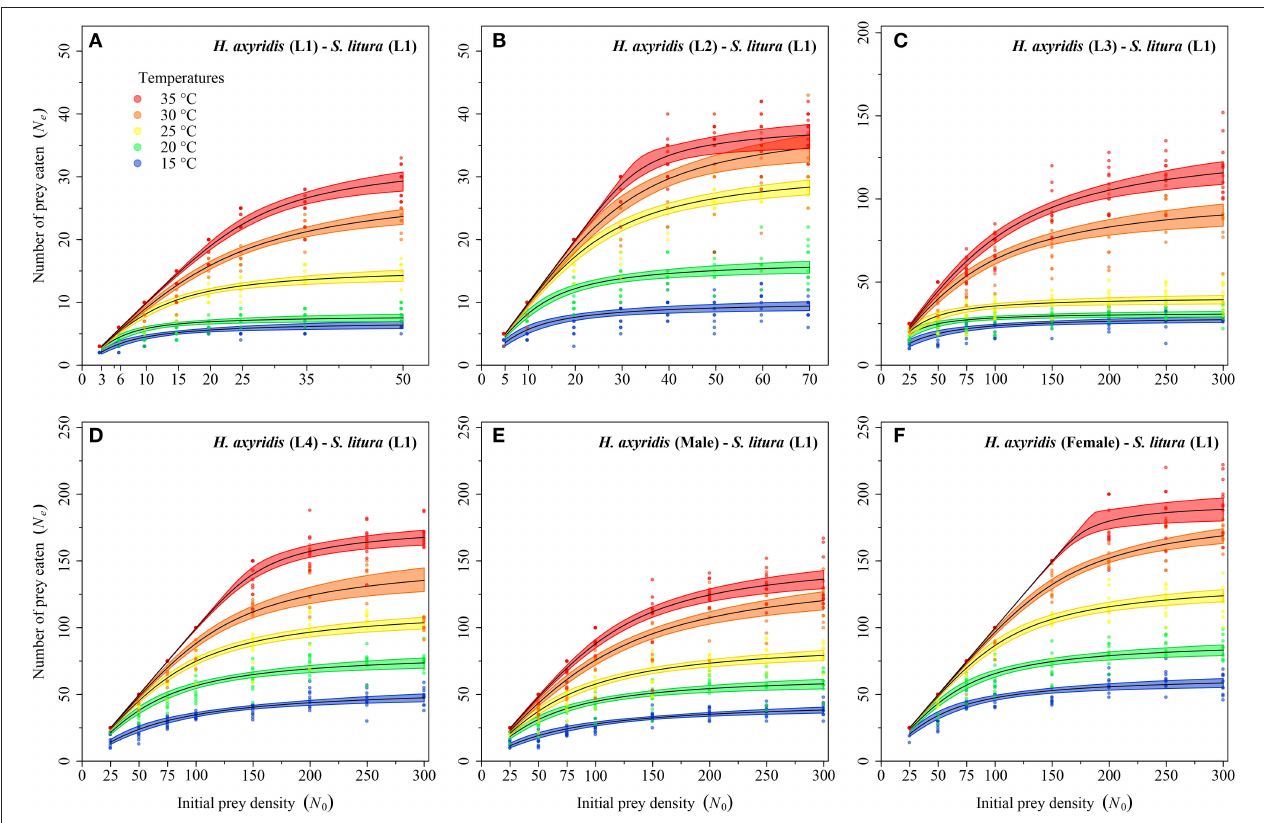
FIGURE 3 | Functional response of different stages of Harmonia axyridis [L1-Female (A–F) ] foraging on 1st instar of Spodoptera litura . Dots represent the observed numbers of prey consumed at each initial prey density, and black lines were predicted by the Roger’s random predator equation, while the shaded areas represent the limits of the 95% confidence intervals. Number of replications (N) =